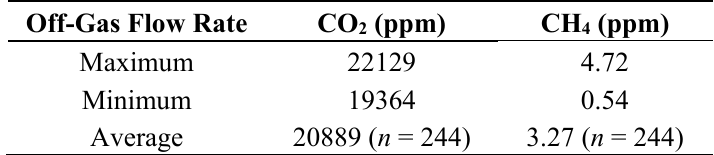
Table 4. CO 2 and CH 4 concentrations measured in the